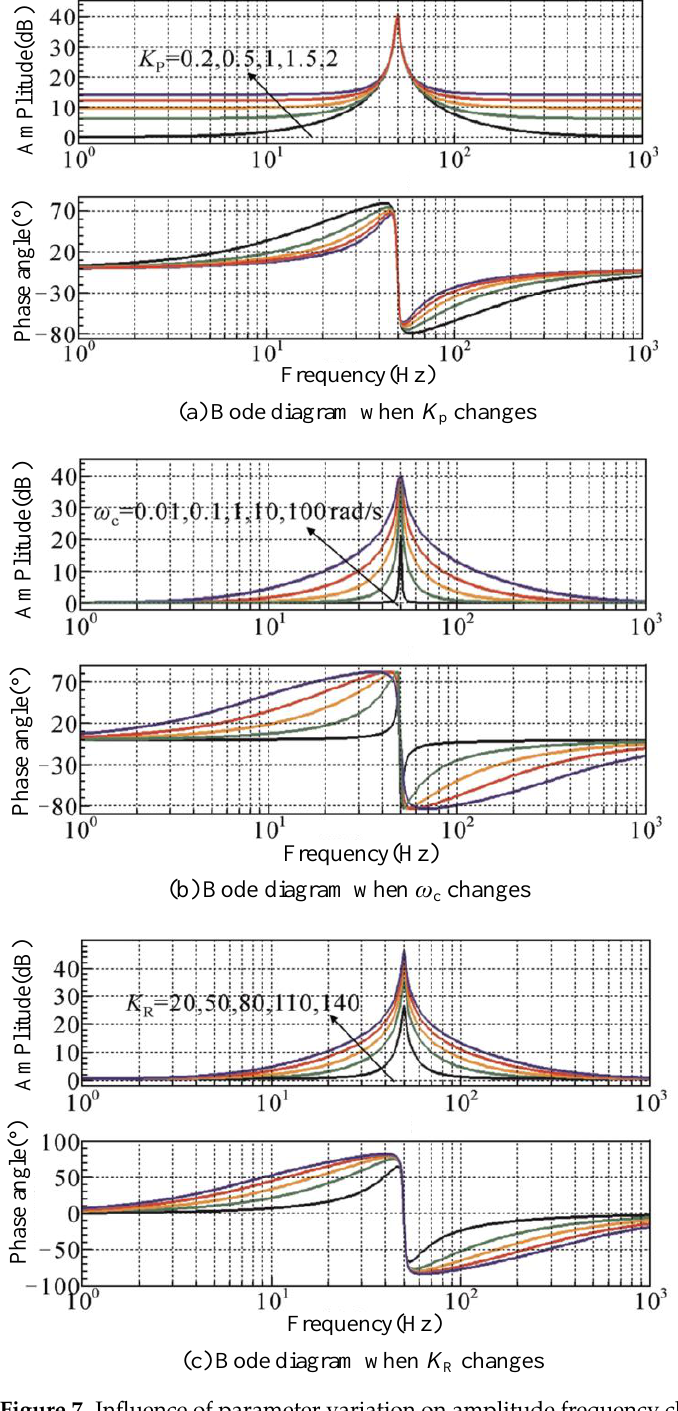
Figure 7. Influence of parameter variation on amplitude frequency characteristics of PR controller.